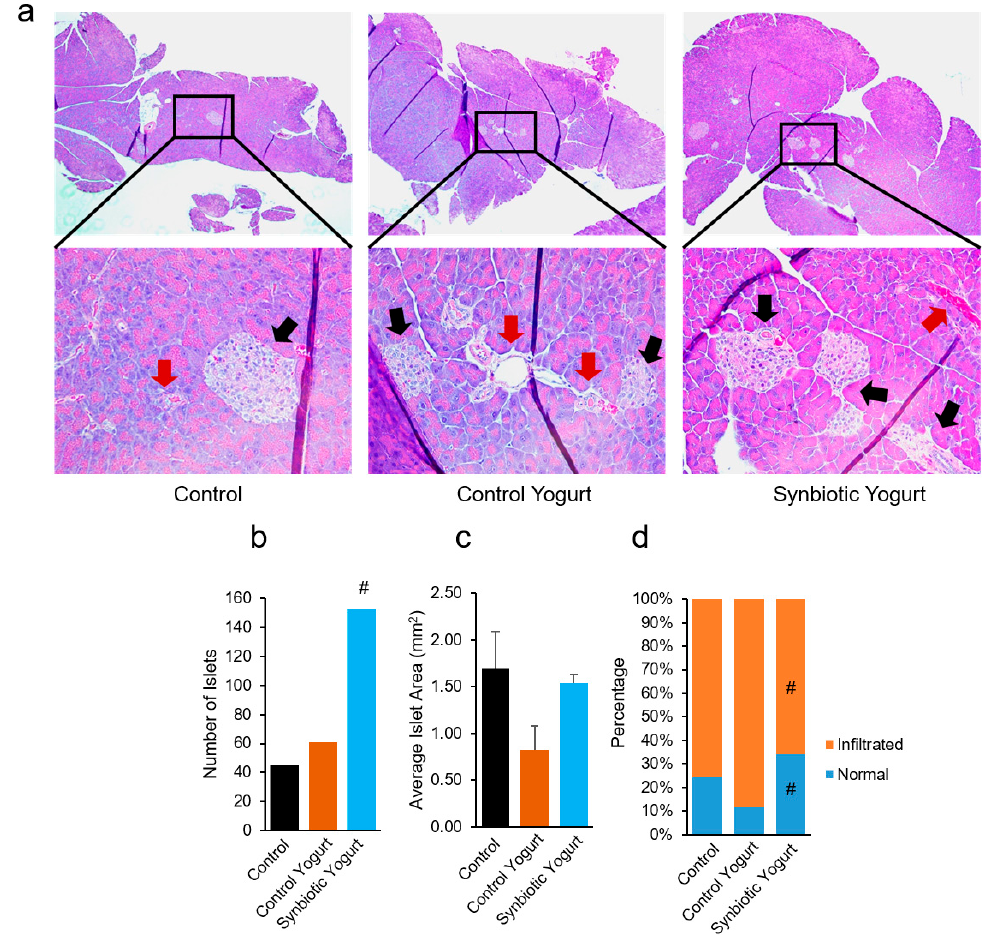
Figure 2. Synbiotic yogurt feeding preserves pancreatic islets and protects against streptozotocin- induced islet damage. ( a ) Histological analyses of pancreatic sections. Black arrows point to islets with normal morphology, while red arrows point to those classified as infiltrated or involuted in shape. ( b ) The total number of islets counted from pancreas sections in each group. ( c ) Average islet area. ( d ) Percent of infiltrated and normal islets in each group. Values are mean ± standard error of the mean (error bars). Values with # p < 0.05 are statistically significant compared to the control yogurt group.